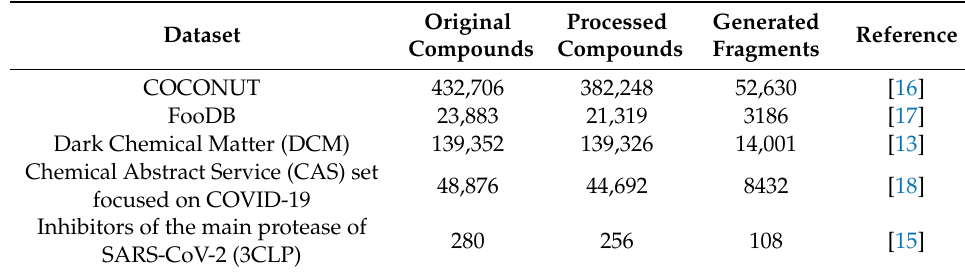
Table 1. Compound data sets analyzed in this